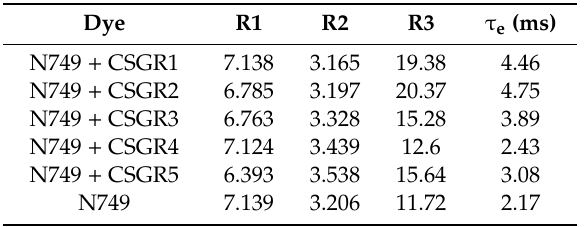
Figure 12. ( a ) EIS Nyquist plots of cocktail DSSC devices of N749 and CSGR dyes measured under a dark condition. ( b ) Bode-Phase plots for cocktail DSSC devices of N749 and CSGR dyes. Table 3. EIS analysis data obtained by fitting in an equivalent